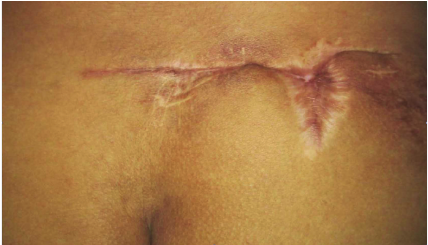
Figure 2: Completely healed wound at one-year